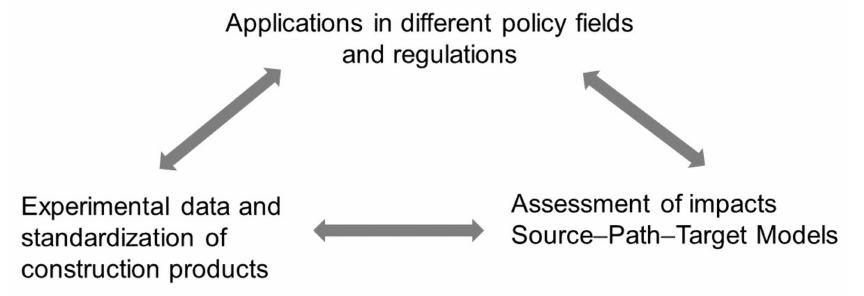
Figure 1. Outline of an integrated approach for construction products over service